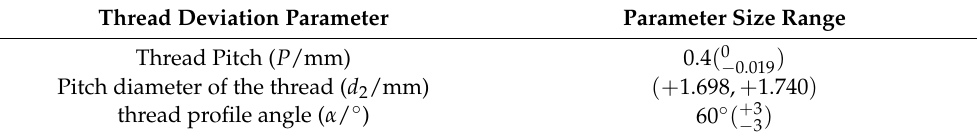
Figure 3. Parametric model of threaded connection. Table 1. Thread geometric deviation parameters.